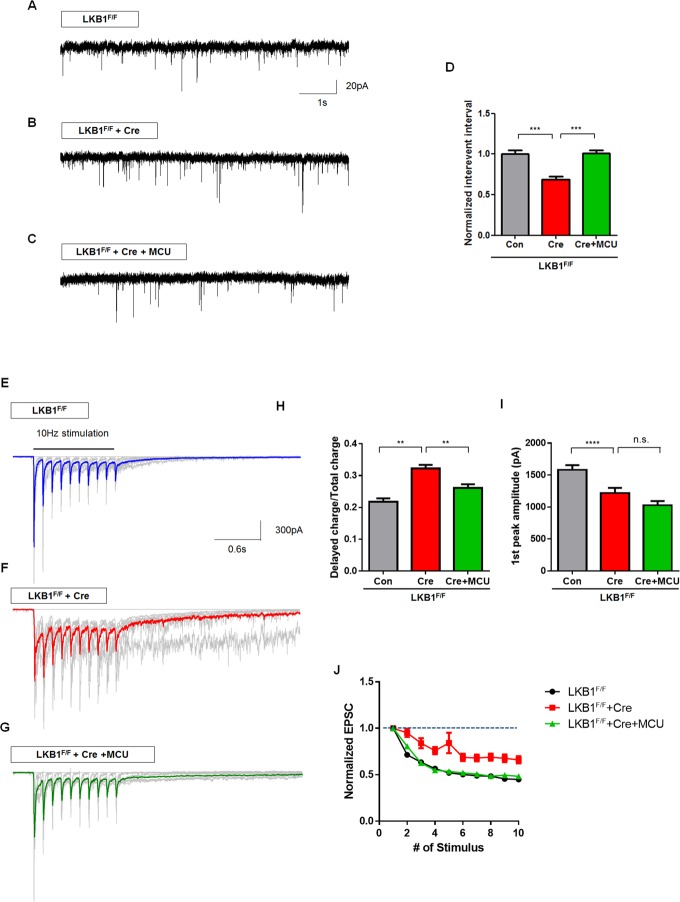
MCU overexpression restores presynaptic release properties in LKB1-deficient neurons.(A–D) MCU overexpression by lentiviral infection restored mEPSC frequency in LKB1-deficient cortical neurons. Values were normalized by the average of control from each experiment. n = 1,108 from 27 neurons for control, 1,030 events from 26 neurons for LKB1-deletion, 1,065 events from 21 neurons for LKB1-deletion+MCU. *** p < 0.001, Mann-Whitney test. (E–J) Colored representative traces show the average of nine traces (grey) of evoked EPSC (10 AP at 10 Hz). Increased delayed release observed LKB1-deficient neurons was partially rescued by MCU overexpression (E–H). Peak amplitude of first eEPSC was not rescued by MCU overexpression. (I). MCU overexpression restored short-term depression in LKB1-deleted neurons back to control levels (J). Graph represents normalized EPSC amplitude. n = 140 responses from 20 neurons for control, 169 responses from 17 neurons for LKB1-deletion, 160 responses from 17 neurons for LKB1-deletion+MCU. ** p < 0.01, **** p < 0.0001. Mann-Whitney test. Individual values are available in S1 Data.